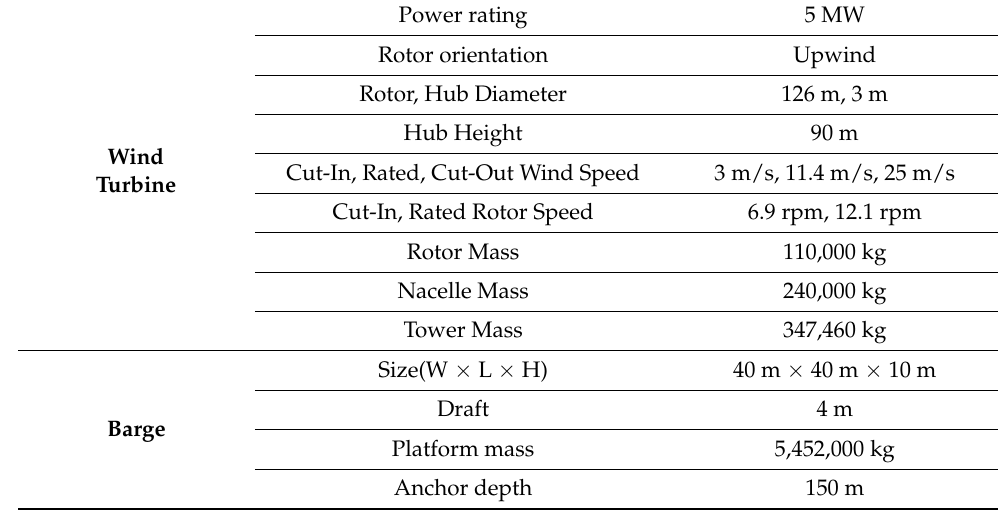
Table 1. Parameters of NREL 5-MW wind turbine and the ITI Energy barge